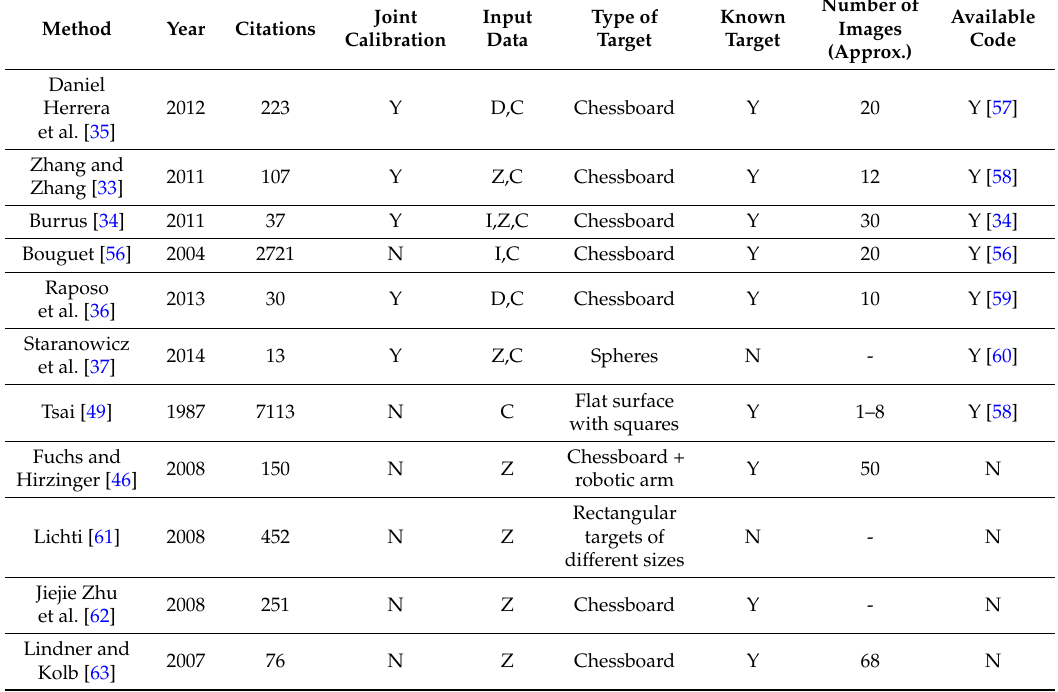
Table 2. Common supervised calibration methods (I = IR, D = Disparity, Z = Depth, C = Color).